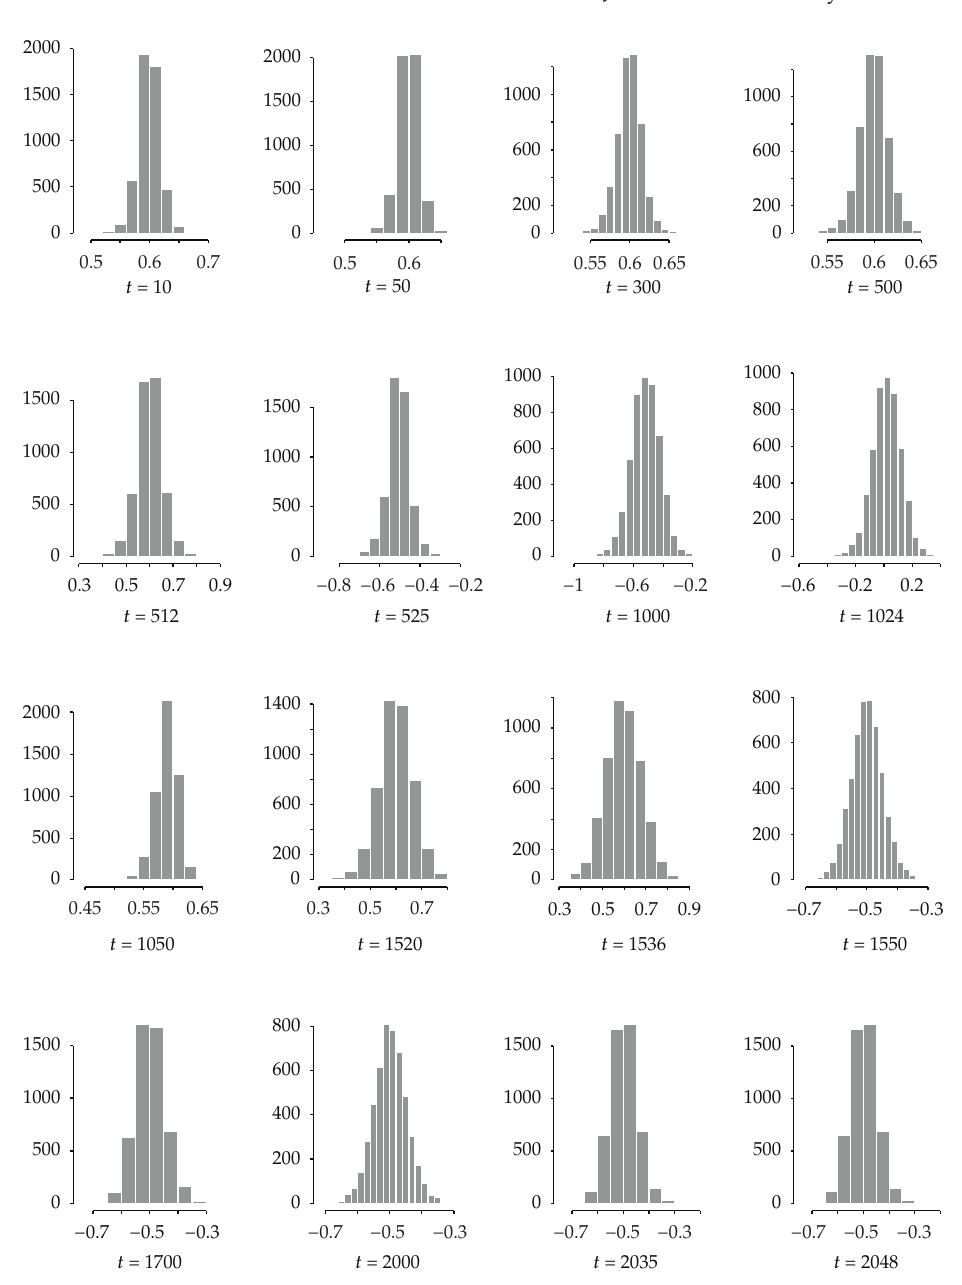
Figure 21: Example 5.3: Histograms of linear estimate of δ 1 at some points of (cid:7) 0, 1 (cid:8)